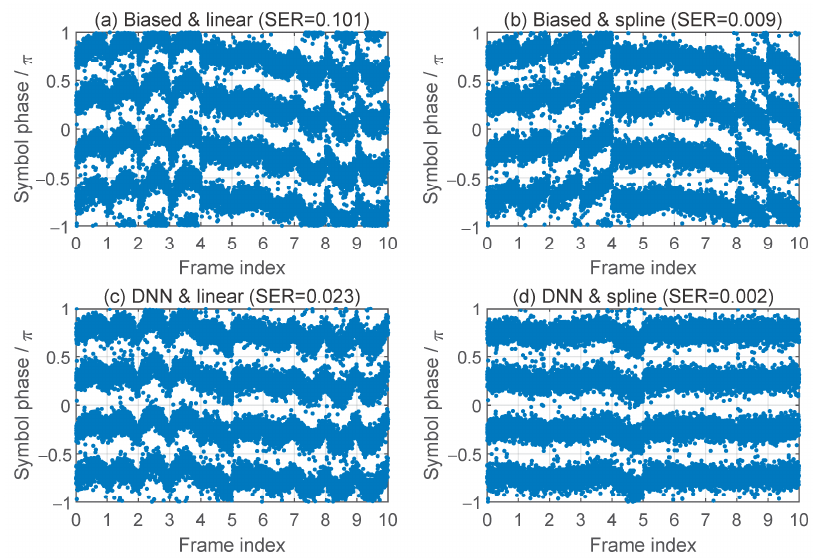
Figure 6. QPSK phase trajectories and symbol error rates (SERs) in the experimental verification ( a ) Biased LFM with linear interpolation ( b ) Biased LFM with spline interpolation ( c ) DNN-unbiased with linear interpolation ( d ) DNN-unbiased with spline interpolation.